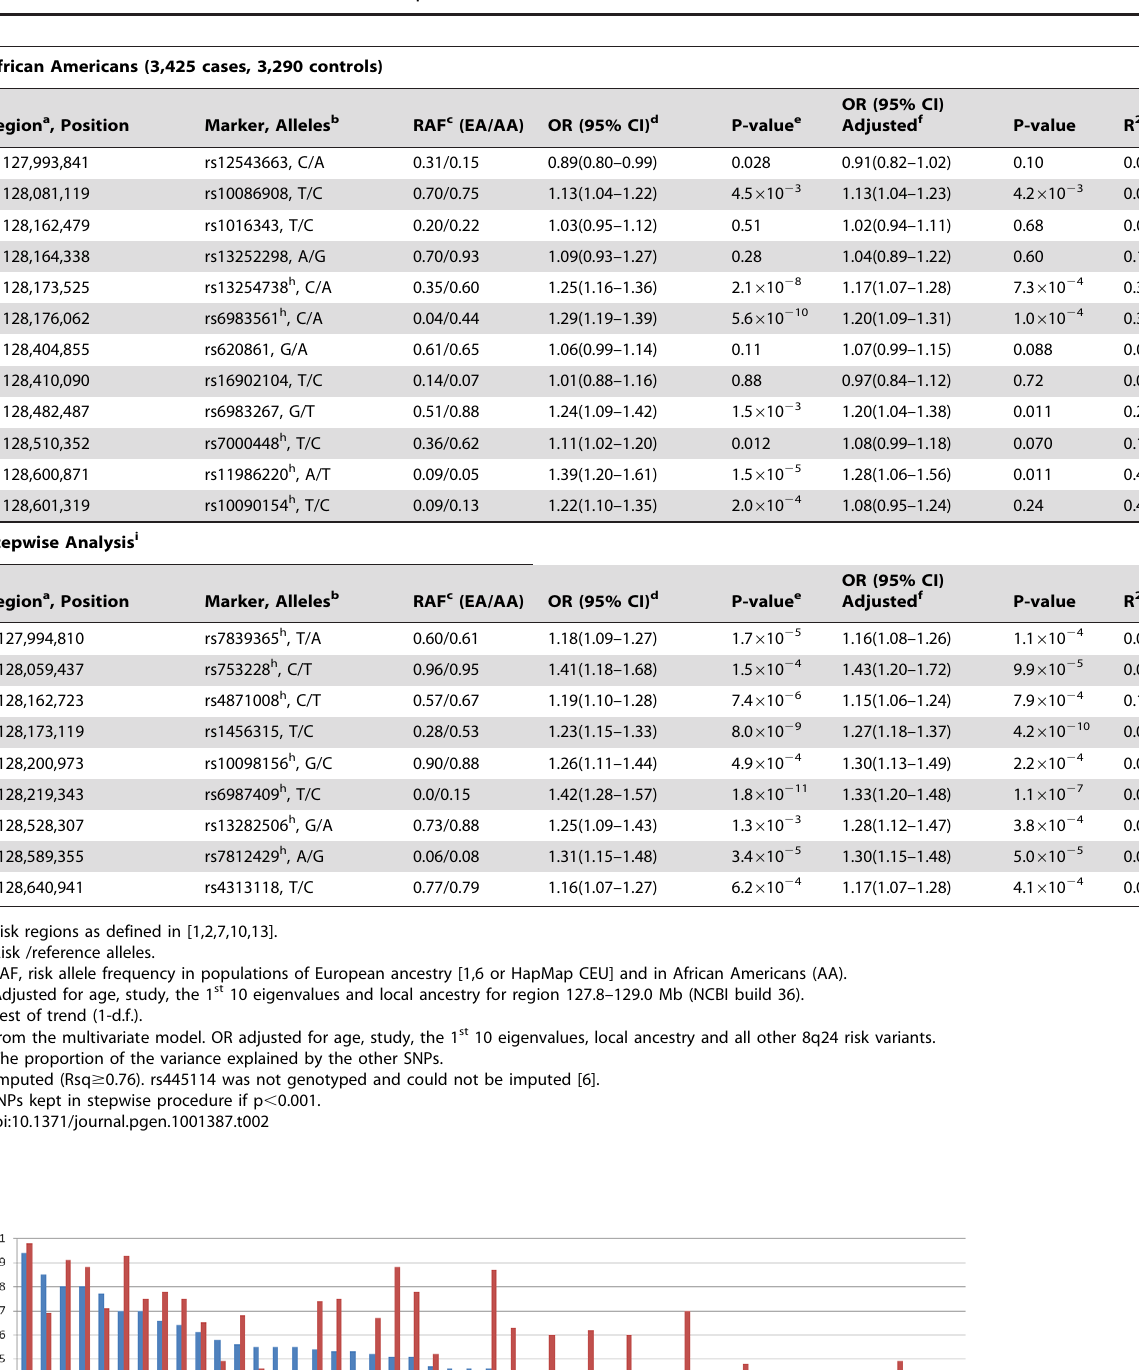
Table 2. Associations with risk variants at 8q24 in African Americans.